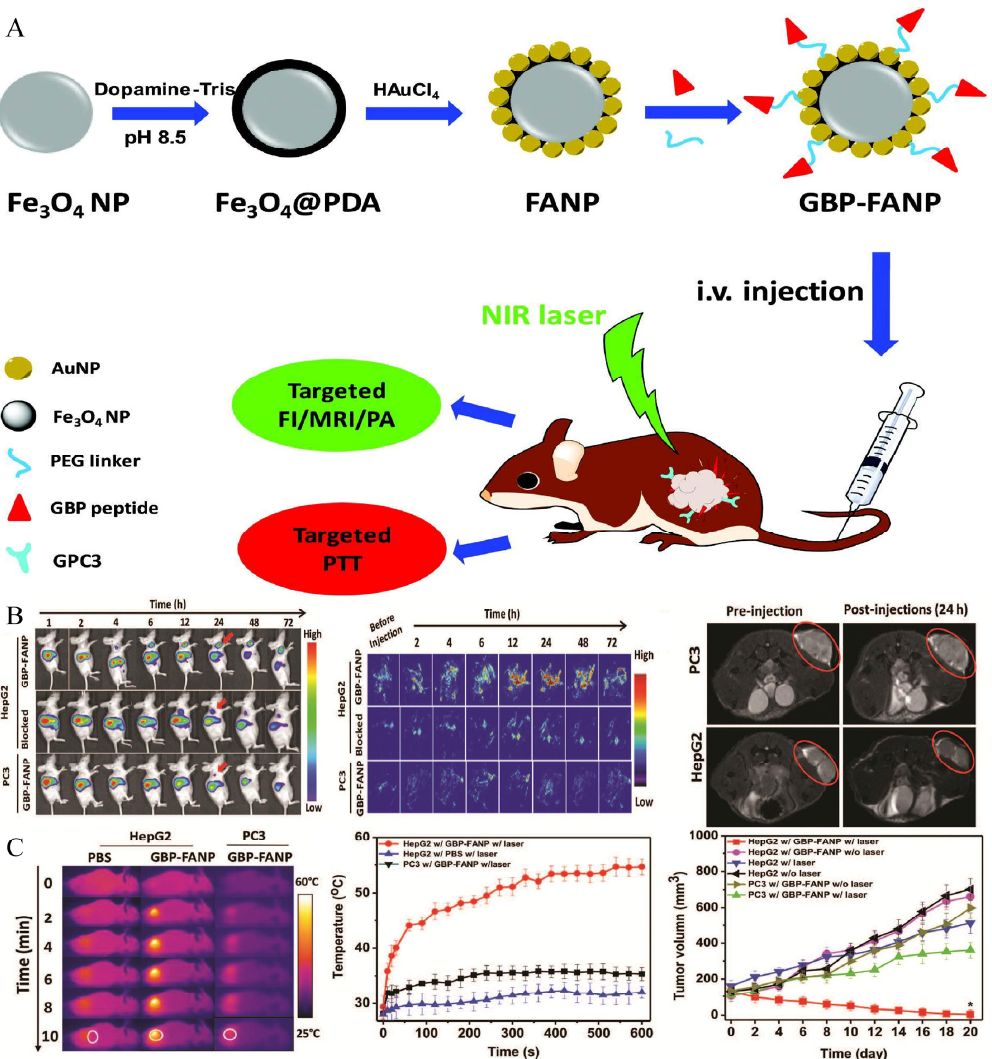
Figure 7. The synthesis and theranostic applications of GBP-FANP. Reproduced with permission Ref. [49]. Copyright 2019 Royal Society of Chemistry. ( A ) The synthesis of GBP-FANP and design of trial. ( B ) Non-invasively targeted MR imaging, fluorescence imaging and photoacoustic imaging in vivo. ( C ) Photothermal treatment effect of